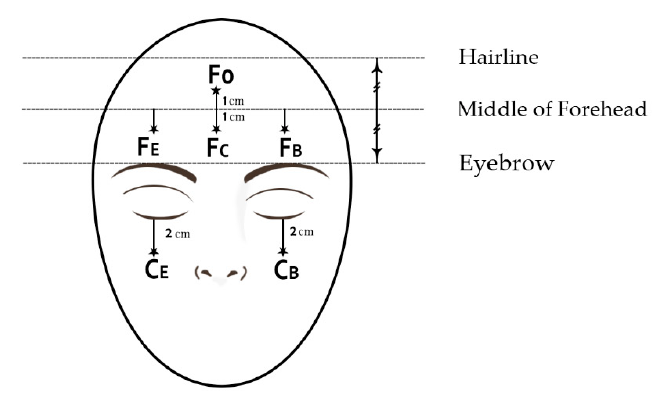
Figure 1. Positions on facial skin for specified methods of treatment. F 0 = unwashed (non-treatment) on forehead; F C = washed only (control treatment) on forehead; F B = washed + toner base on forehead; F E = washed + emblica toner on forehead; C B = washed + toner base on cheek; C E = washed + emblica toner on cheek.